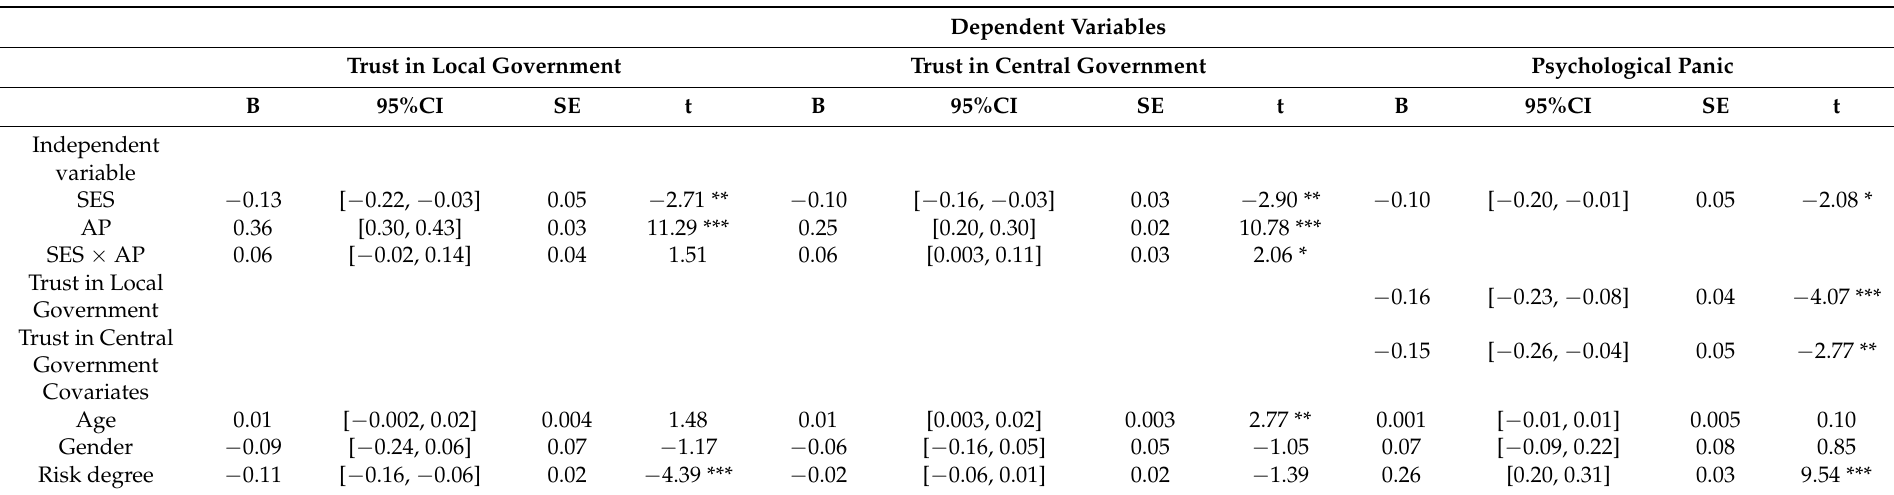
Table 3. Results of regression analysis predicting trust in government and psychological panic (N =